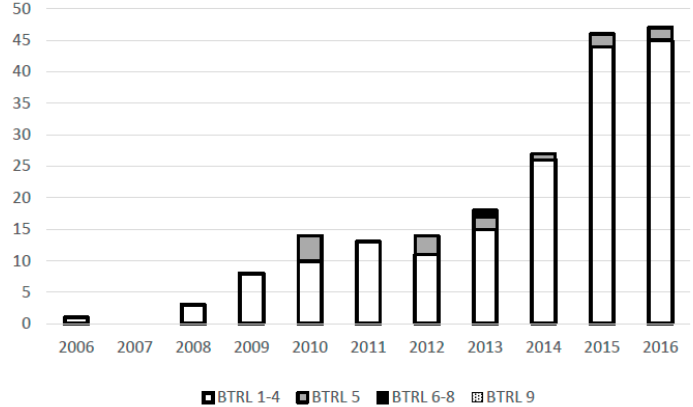
Figure 4. Distribution of bioprinting original articles according to the bioprinting technology readiness level (BTRL). The 2006–2015 bioprinting articles were analyzed and distributed into 4 groups: 1 (in vitro, BTRL 1–4), 2 (animal-in vivo, BTRL 5), 3 (human-clinical grade, BTRL 6–8) and 4 (industrial, BTRL 9). There has never been any paper in group 4. Table 1. Bioprinting technology readiness level (BTRL) scale, adapted from the Medical Devices scale of the Medical Research and Materiel Command (MRMC) [18].